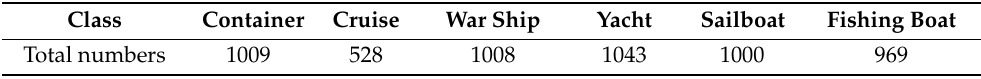
Table 1. The composition of self-built ship data